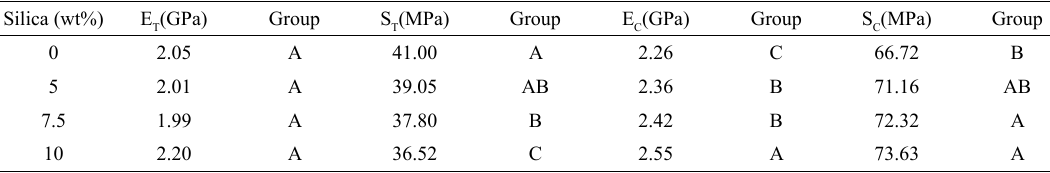
Table 3. Mechanical properties for particulate reinforced epoxy polymer (Tukey test).